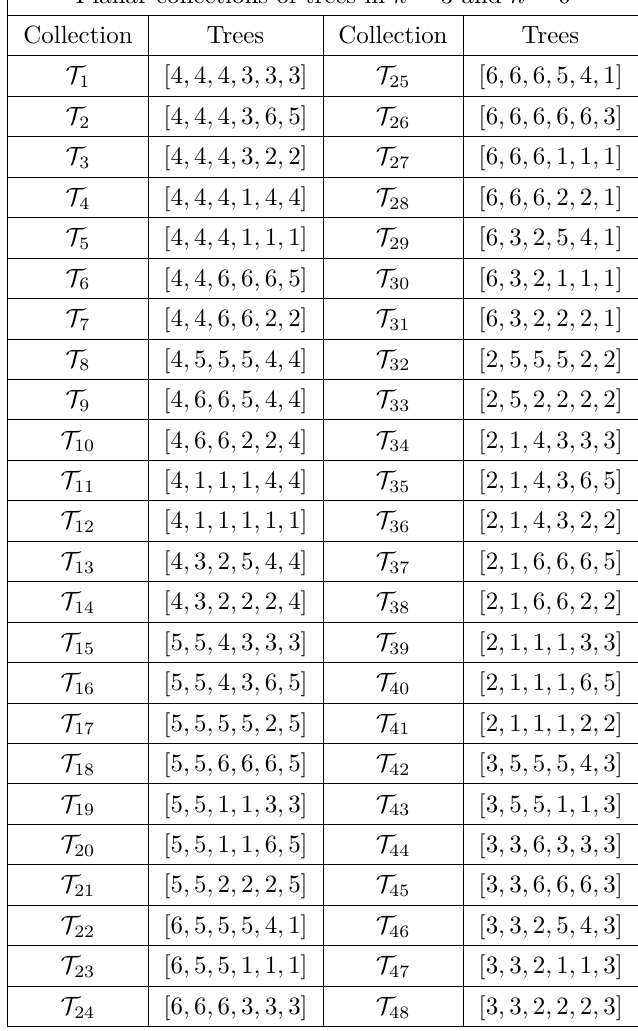
Table 1 . All 48 planar collections of trees for n = 6 in a compact notation tailored to this case and explained in the